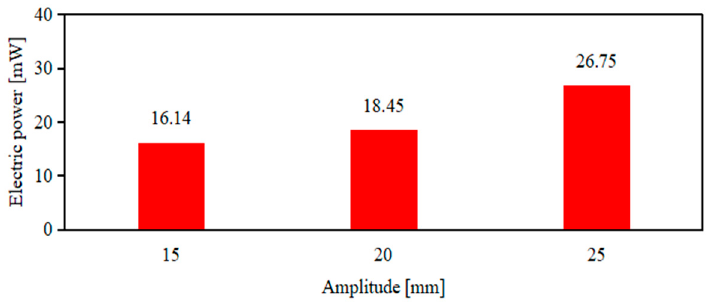
Figure 21. Results of comparing average electrical power with different amplitude.